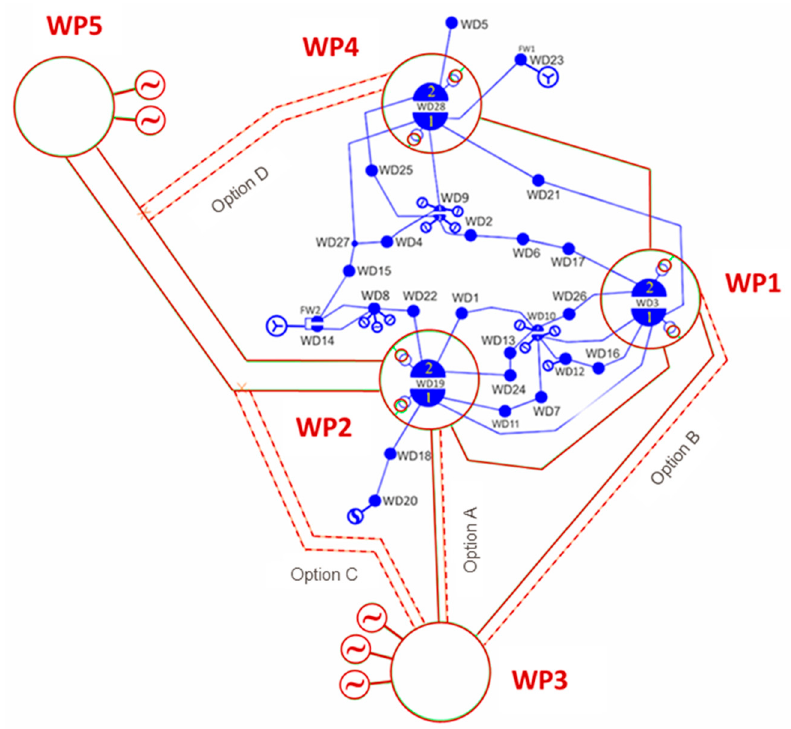
Figure 5. The two-voltage test network adopted for the calculation in the example.